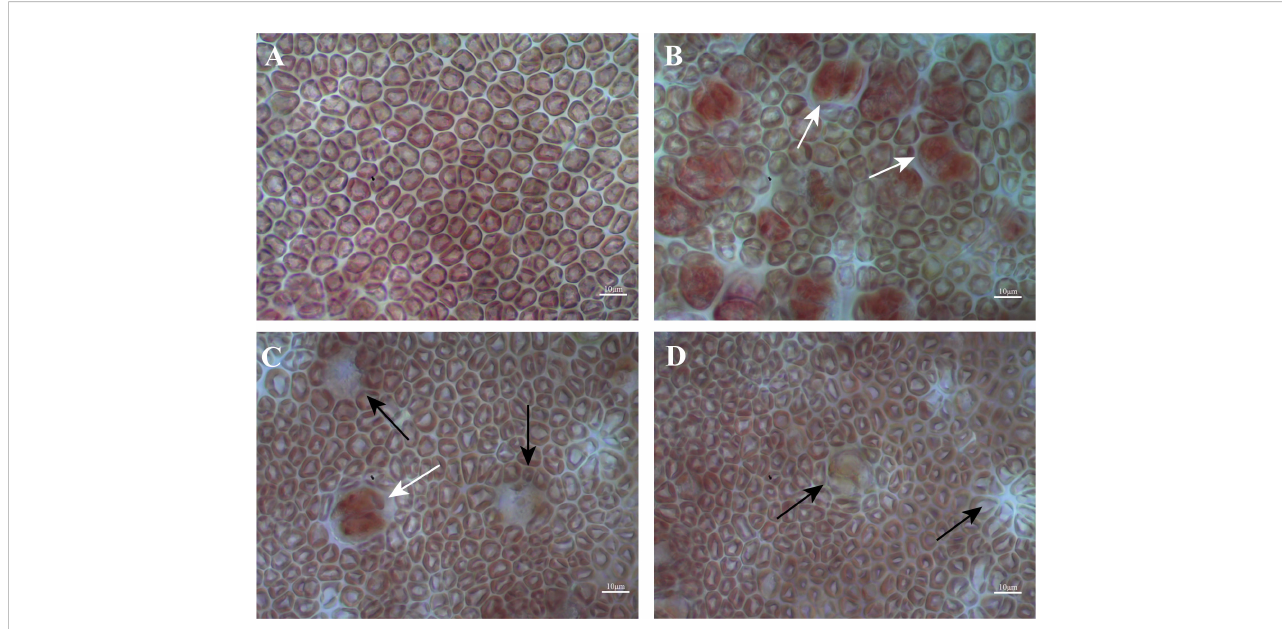
FIGURE 1 Four phases in the development of the tetrasporangium of G. lemaneiformis . (A) Phase I; (B) Phase II; (C) Phase III; (D) Phase IV. Scale bars represent 10 m m. The red arrows indicate tetrasporangium, white arrows indicate holes left after tetraspore